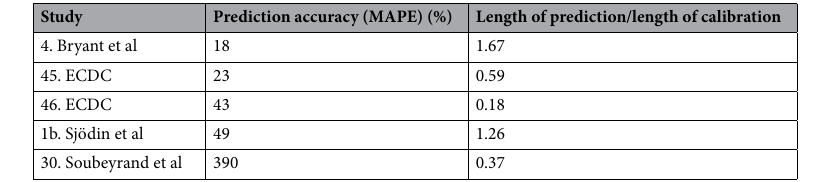
Table 3. Comparison of model accuracy for models that predicted the cumulative number of death due to COVID-19 in Sweden during 2020.